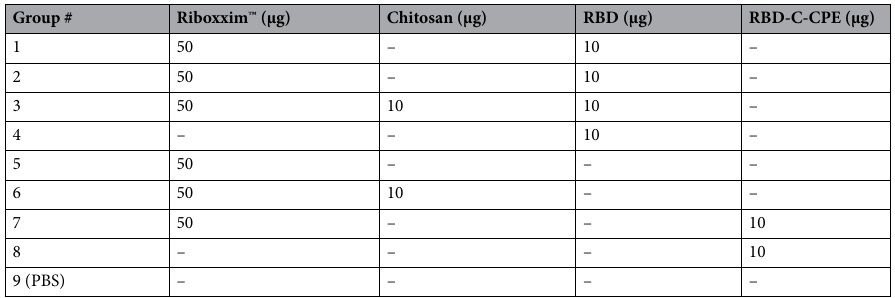
Table 1. Groups of mice immunized with different formulations of monovalent SARS-CoV-2 RBD vaccines. Nine groups of mice (n = 5 animals per group) were immunized with monovalent SARS-CoV-2 RBD vaccines of the indicated formulations. RBD-cCPE: receptor binding domain fused to the C-terminal polypeptide of the C. perfringens toxin (cCPE), which targets Claudin-4 on microfold (M) cells. Riboxxim™: Synthetic, double- stranded RNA TLR3/RIG-I agonist.